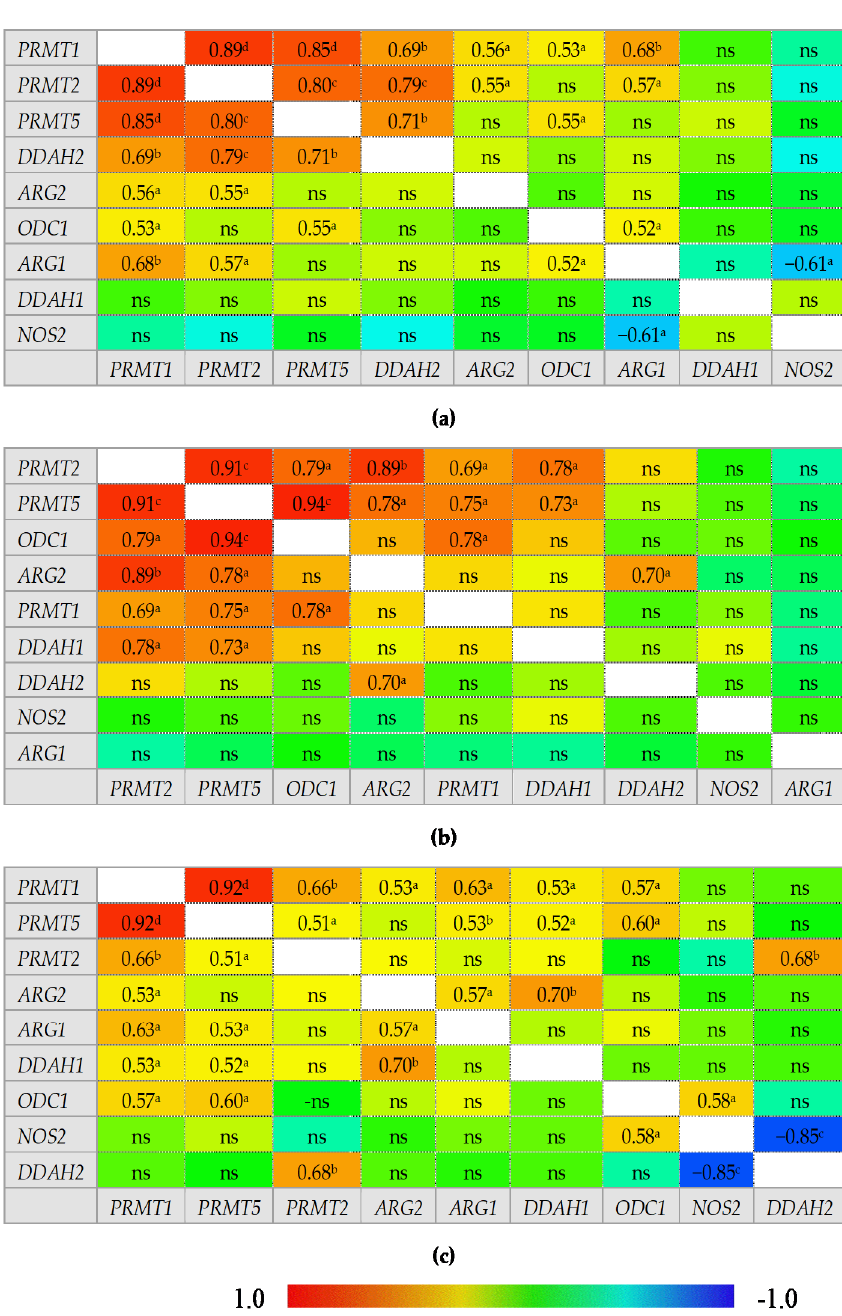
Figure 6. Correlogram for genes encoding L-arginine/NO pathway enzymes: ( a ) in quiescent large bowel from patients with Crohn’s disease; ( b ) in inflamed large bowel from patients with Crohn’s disease; ( c ) in inflamed large bowel from patients with ulcerative colitis. Results presented as correlation coefficients r and analyzed on log-transformed data using Pearson’s correlation test; a p < 0.05; b p < 0.01; c p < 0.001; d p < 0.0001; ns, non-significant; ARG, arginase; DDAH, dimethylarginine dimethylaminohydrolase, NOS, nitric oxide synthase; ODC, ornithine decarboxylase; PRMT, arginine N-methyltransferase.